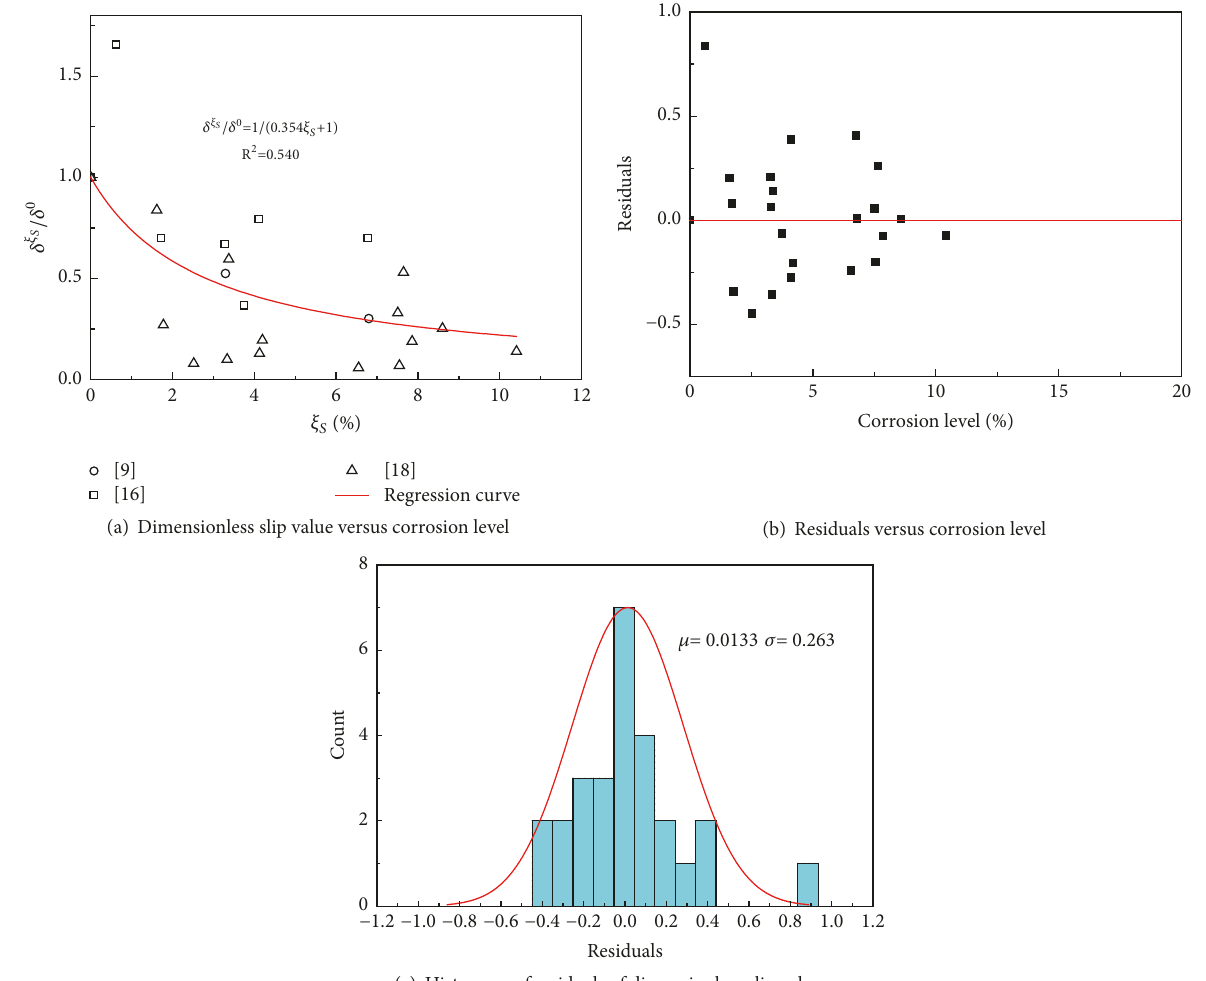
Figure 2: Dimensionless slip value corresponding to bond strength of pull-out specimens with plain rebar: (a) dimensionless slip value versus corrosion level; (b) residuals versus corrosion level; (c) histogram of residuals of dimensionless slip